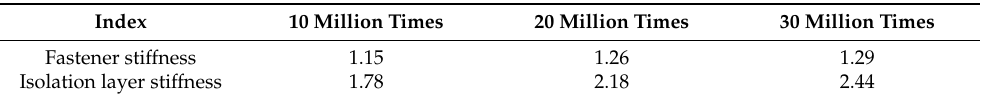
Table 3. Ratio of fastener and isolation layer stiffness to the initial under different load action times.